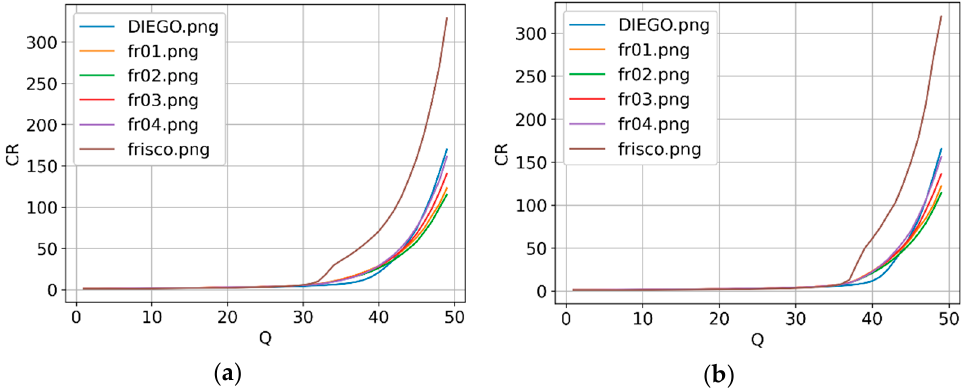
Figure 4. Dependences of CR on Q for noise variance equal to 64 ( a ) and 196 ( b ).